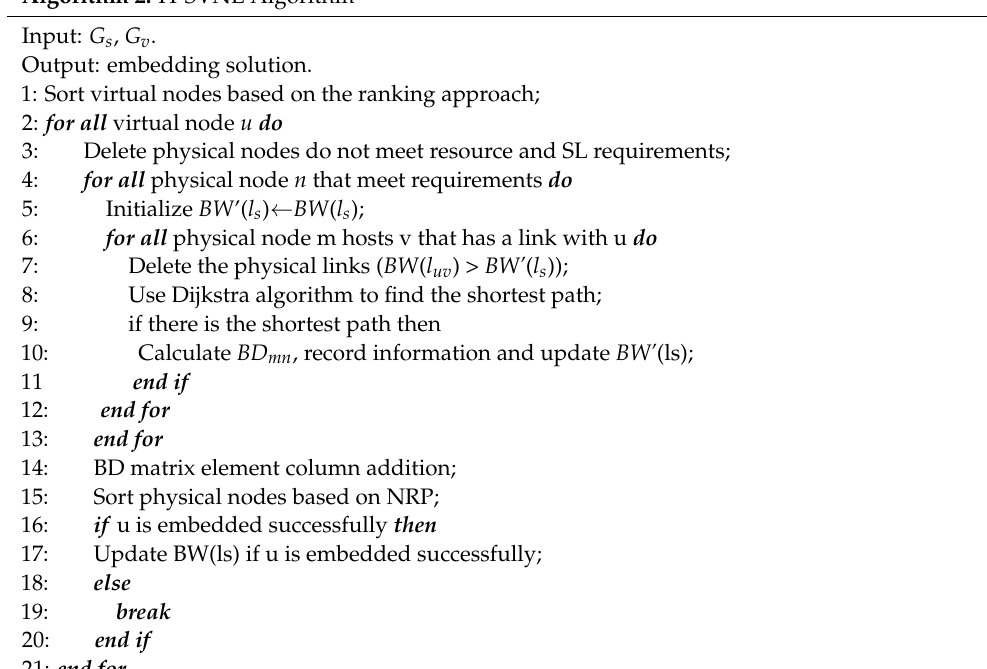
Algorithm 2: H-SVNE